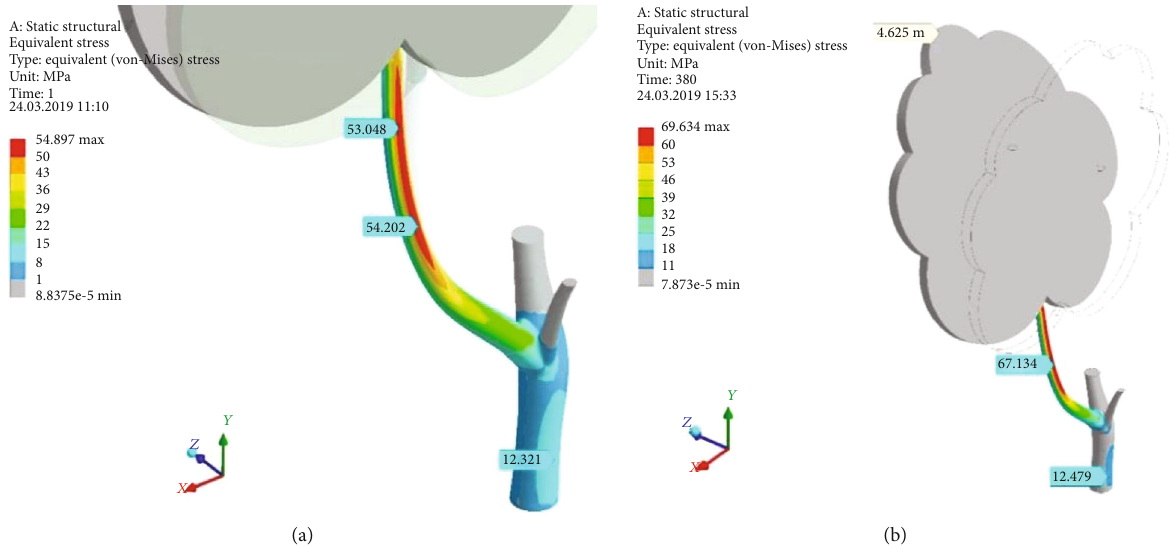
Figure 14: Equivalent stress distribution ( σ e ) (MPa) for the linear solution ( a ) and for the geometrically nonlinear one ( b ; stepped loading). Peak wind pressure ð p wind peak Þ = 600 Pa; ×